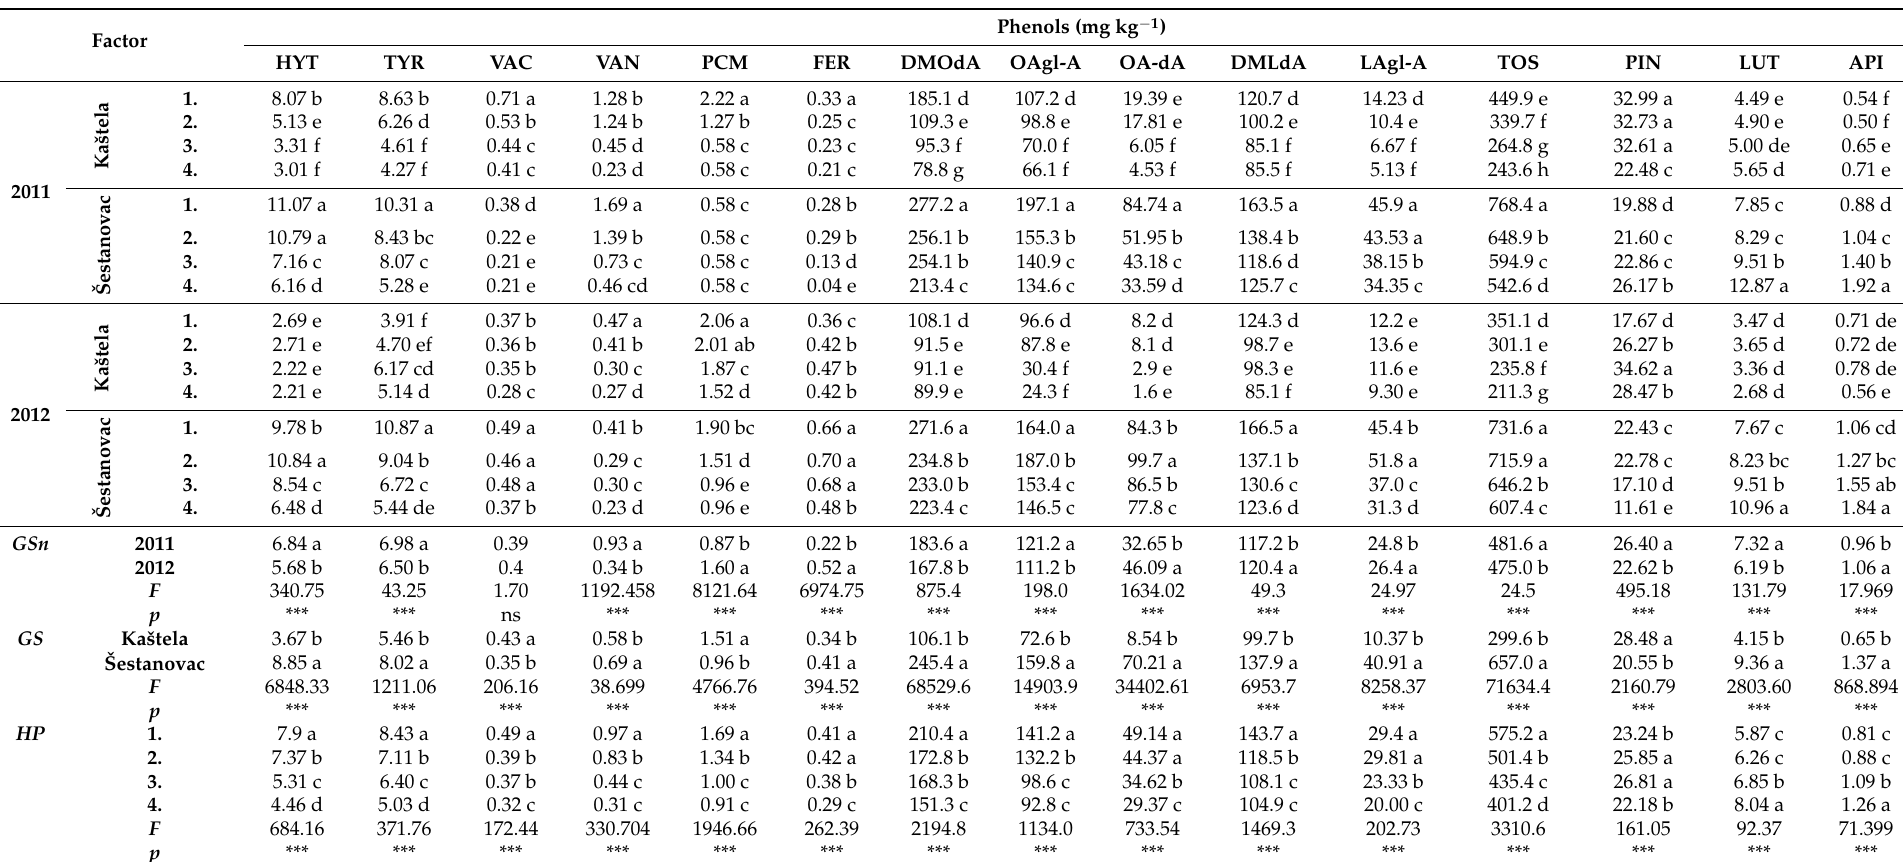
Table 1. Phenolic profile of Oblica virgin olive oils during ripening obtained from two distinct olive orchards (Kaštela and Šestanovac) in two successive growing